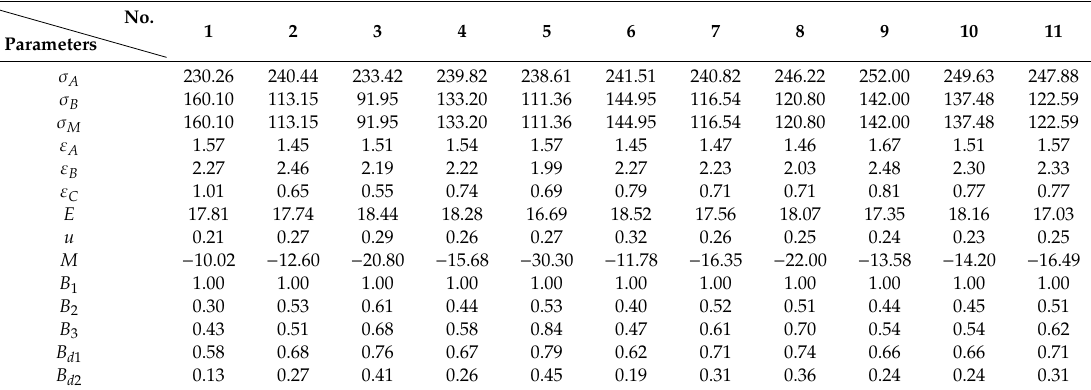
Table 4. Evaluation form of shale unloading brittleness index.